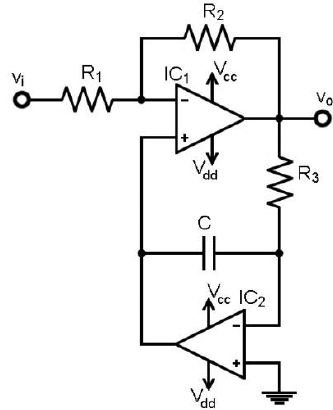
Figure 2. Starting design: high-pass filter with